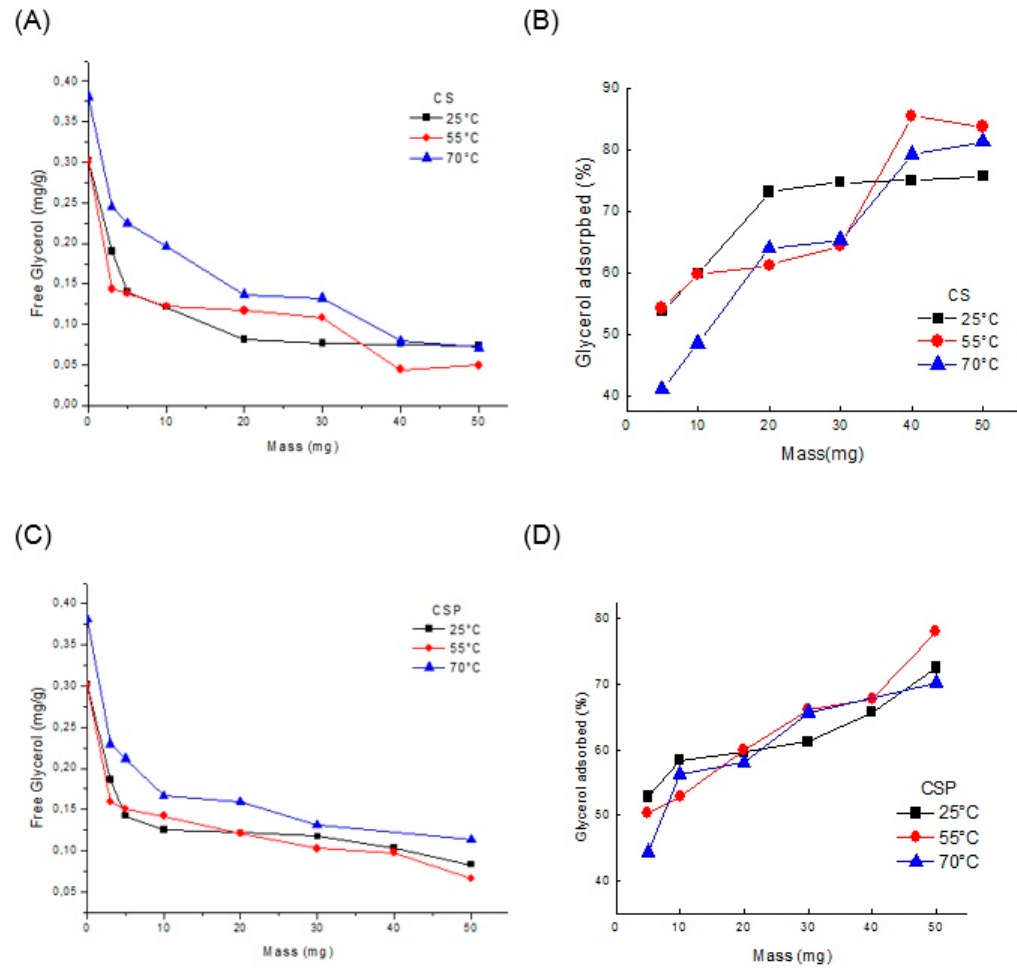
Figure 5. Influence of adsorbent loading on glycerine removal by CS ( A , B ) and CSP ( C , D ) for different temperatures .